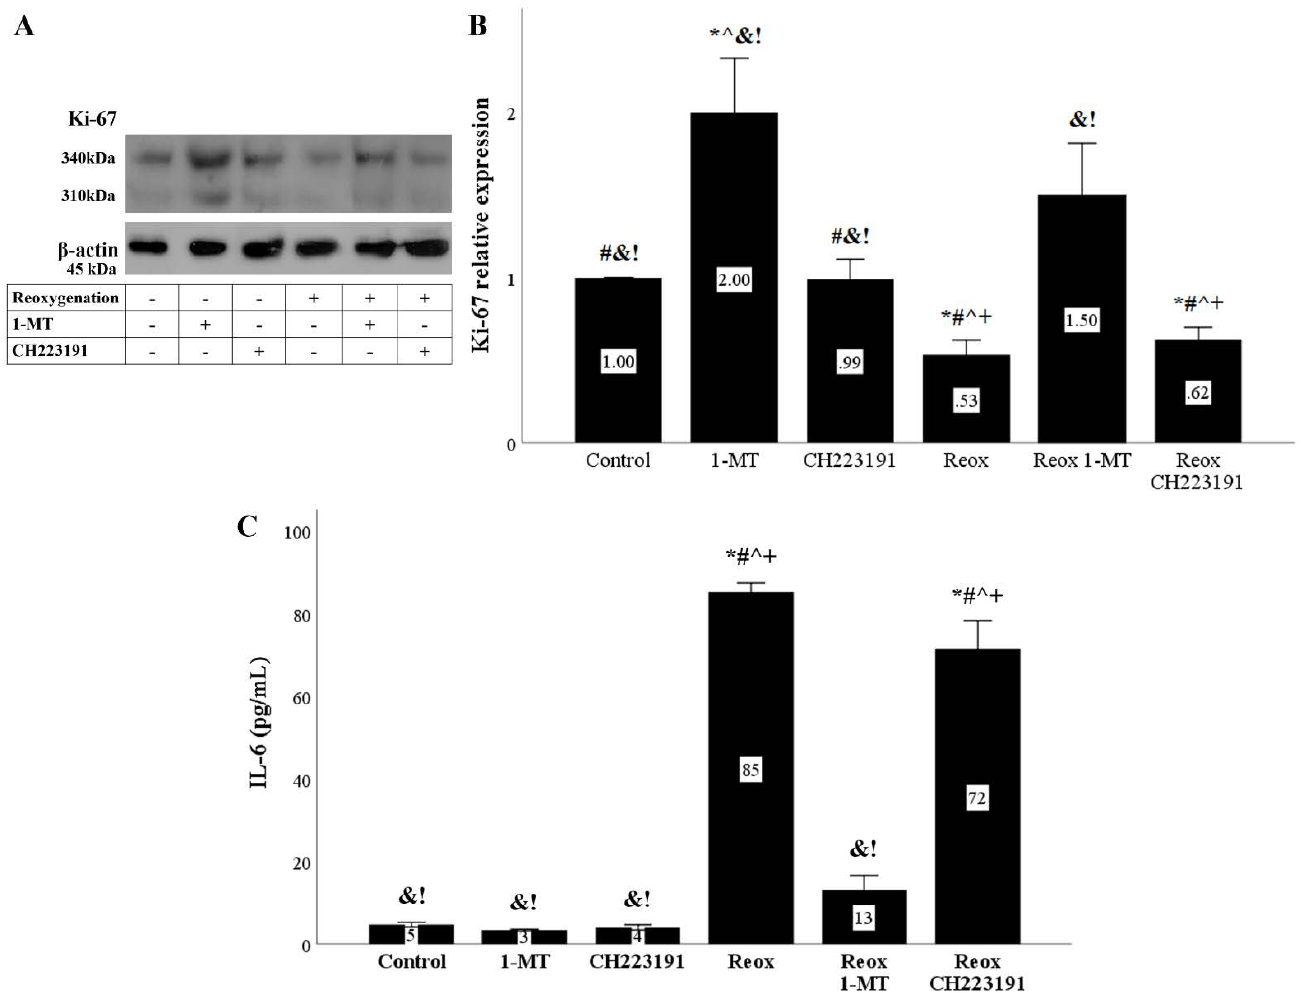
Figure 11. Reoxygenation inhibits cell proliferation and induces IL-6 production in an IDO dependent manner. Cells were cultured under anoxic conditions for 24 h and then subjected to 2 h of reoxygenation along with the indicating treatments. Reoxygenation reduced the levels of the cell proliferation marker Ki-67. The IDO inhibitor 1-MT restored Ki-67 levels, whereas the AhR inhibitor CH223191 did not affect Ki-67. A representative Western blot experiment is displayed in panel ( A ), whereas panel ( B ) depicts the cumulative results of four repeated experiments. Reoxygenation increased IL-6 concentration in the RPTECs culture supernatants. 1-MT reduced the reoxygenation-induced IL-6 production, whereas CH223191 did not affect IL-6 levels ( C ). Six such experiments were performed. * p < 0.05 vs. Control, # p < 0.05 vs. Control with 1-MT, ^ p < 0.05 vs. Control with CH223191, & p < 0.05 vs. Reox, + p < 0.05 vs. Reox with 1-MT, ! p < 0.05 vs. Reox with CH223191. Error bars correspond to SEM. 1-MT, 1-DL-methyltryptophan; IL-6, interleukin-6; Reox, reoxygenation.